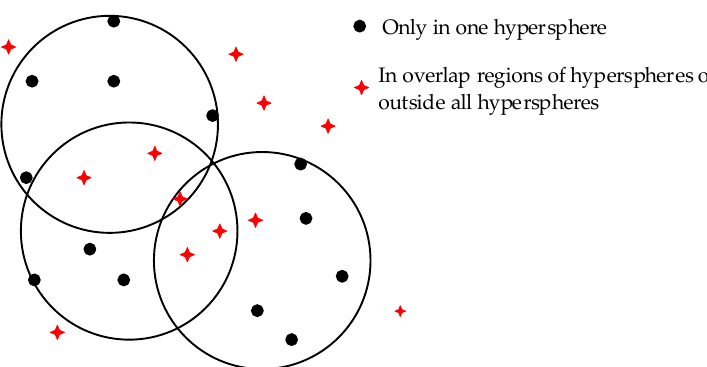
Figure 1. Schematic diagram of positional relationship between samples and hyperspheres.